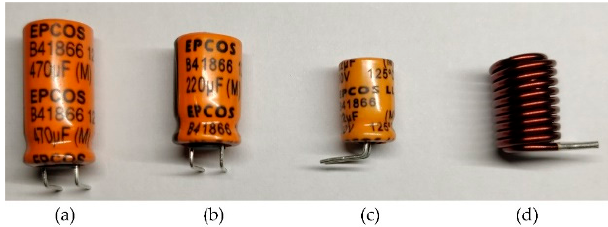
Figure 3. Four electronic components: ( a ) capacitor of 470 µ F; ( b ) capacitor of 220 µ F; ( c ) capacitor of 22 µ F; ( d ) inductor.